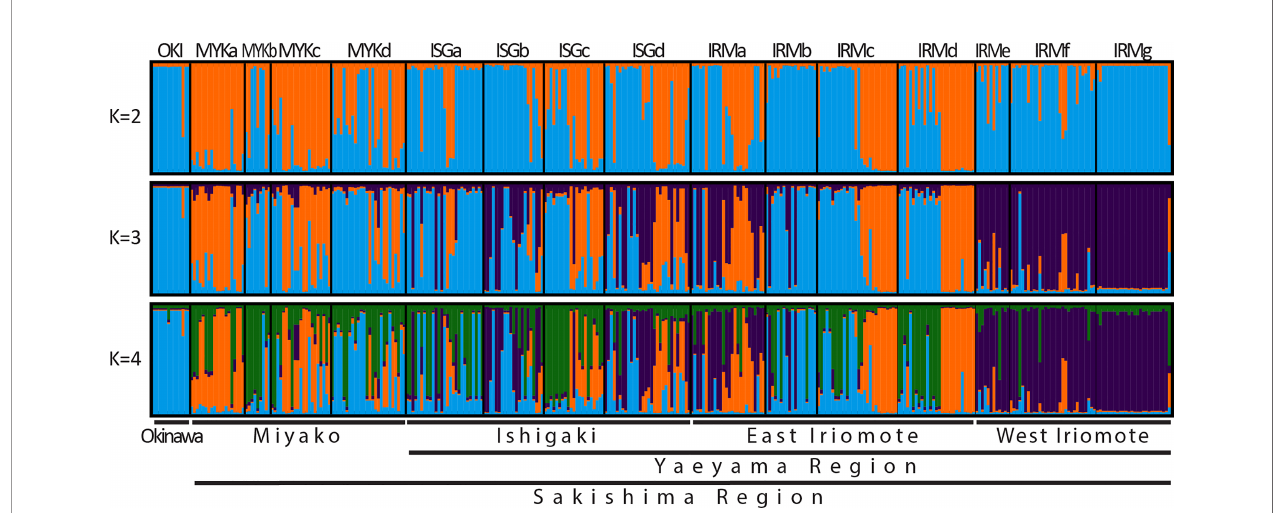
FIGURE 5 | The optimal number of genetic clusters was 3 (K= 3); clustered with inferred ancestry from the west coast of Iriomote Island (WCI) (purple), from Miyako Island (orange), from Okinawa mainland (blue). Each bar represents an individual sample. The cluster from OKI was distributed throughout the Archipelago, but its ratio drastically declined at WCI (IRMe-g), while the cluster from WCI revealed very limited distribution, even among neighboring sites on Iriomote Island. Heterogeneous genetic structures were found at most sampling sites, except for IRMg and OKI, and such patterns were consistent from the results with K= 4, but not with K=2 where both clusters are distributed throughout the archipelago.